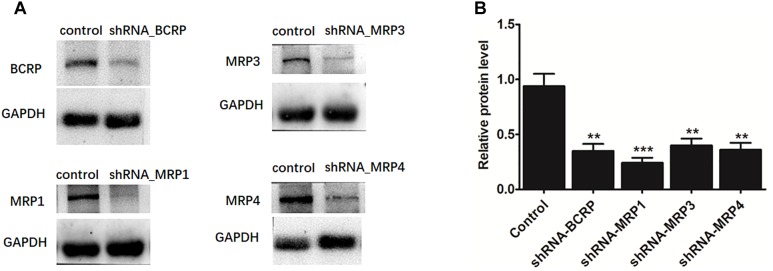
The protein expression (A) and efficiency of the knockdown (B) of BCRP, MRP1, MRP3, and MRP4 in HeLa1A9 cells after stable transfection of BCRP-shRNA, MRP1-shRNA, MRP3-shRNA, and MRP4-shRNA into HeLa1A9 cells, respectively. All the experiments were conducted in triplicate. ∗p < 0.05, ∗∗p < 0.01, and ∗∗∗p < 0.001 relative to the parameters of the control cells (scrambled shRNA transfection).